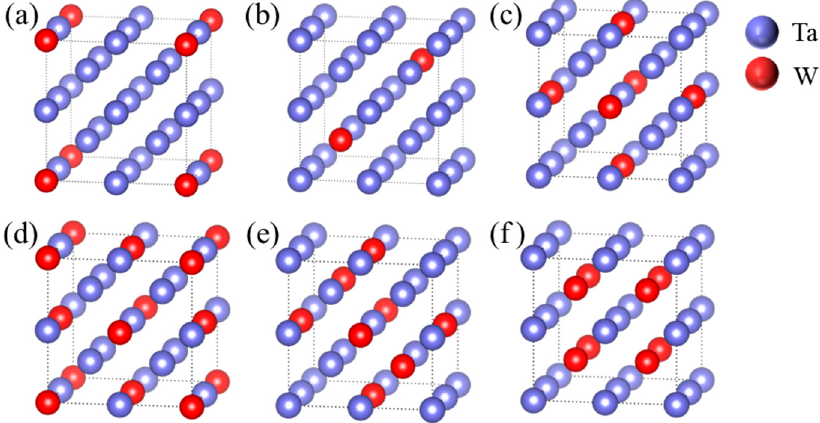
Figure 1. Atomic structure models of Ta–W alloys. ( a ) Ta–6.25W, ( b ) Ta–12.5W, ( c ) Ta–18.75W, ( d ) Ta–25.00W, ( e ) Ta–31.25W, ( f ) Ta–50.00W.